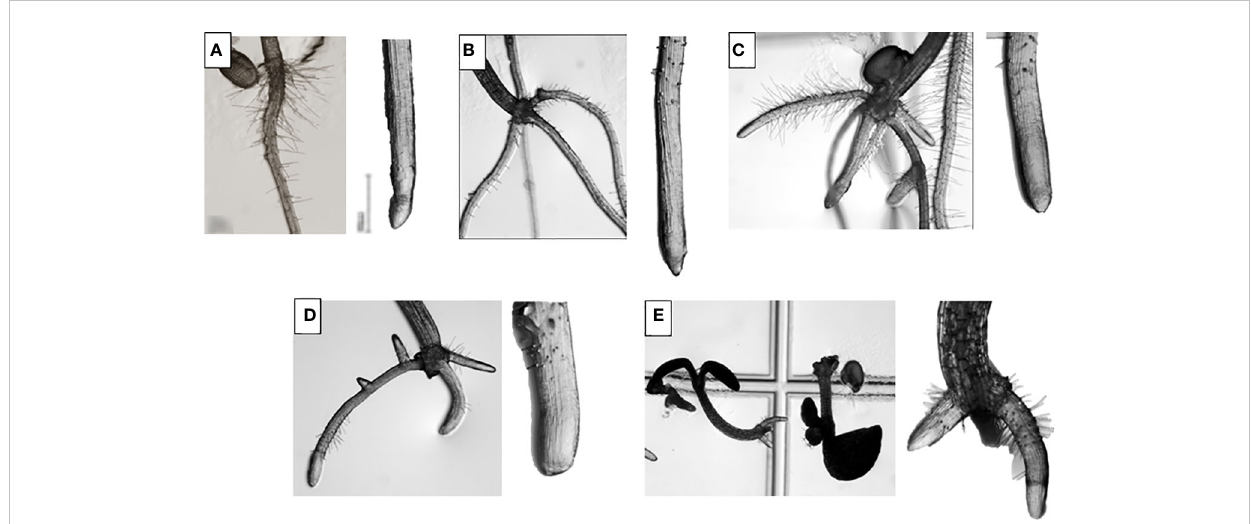
FIGURE 1 Arabidopsis thaliana roots under magni fi er after 14 days of growth treated with 0 (A) , 50 (B) , 100 (C) , 200 (D) and 400 µM (E) of trans